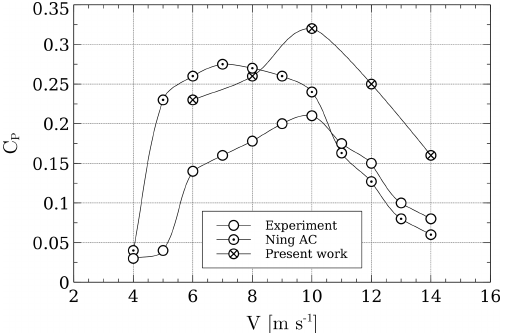
Figure 4. 1.2kW Windspire turbine validation and comparison. λ is kept at 2.3 up until 10ms − 1